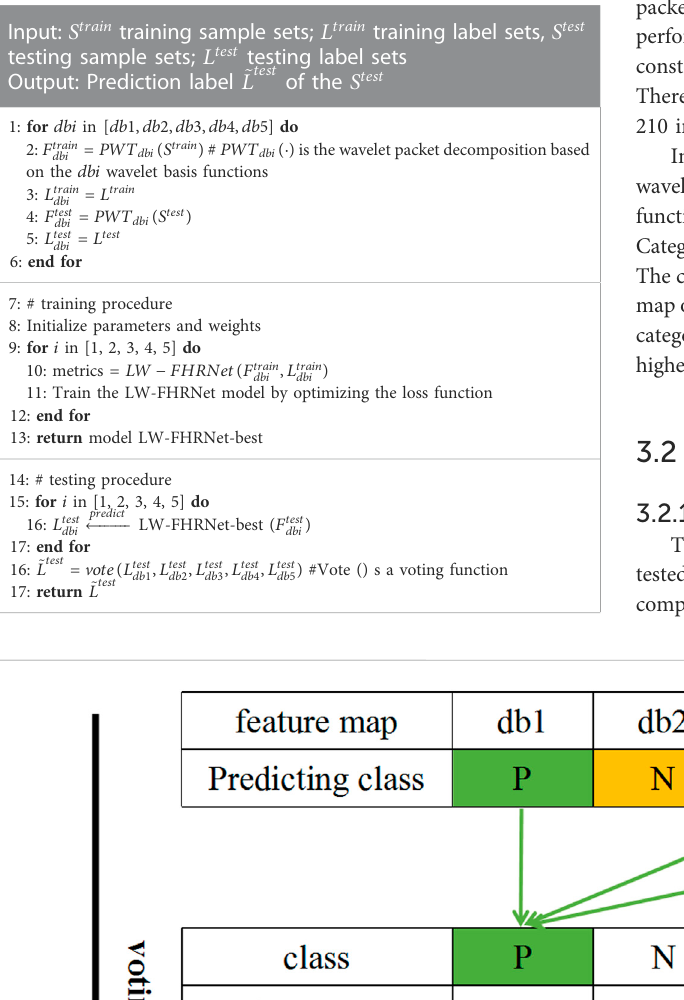
TABLE 2 Details of LW-FHRNet classi fi cation algorithm.